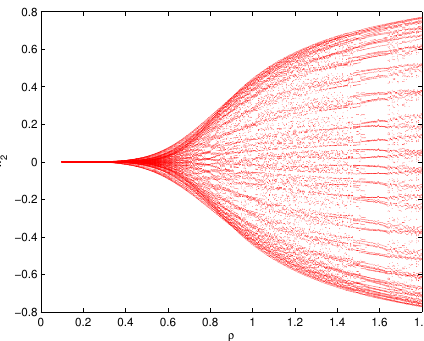
Figure 4. Bifurcation figure of system (95): ρ versus w 2 . The bifurcation value ρ 0 ≈